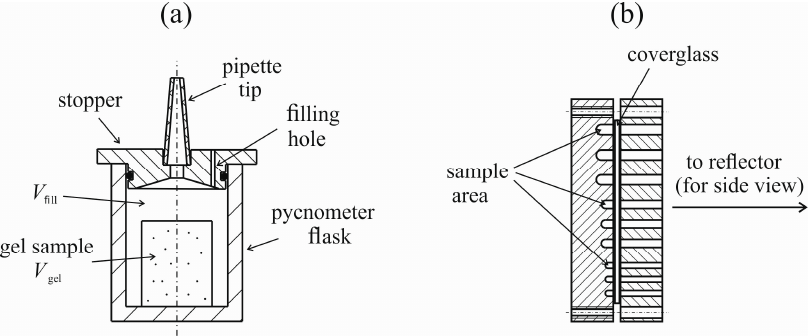
Figure 6. Measurement equipment for natural syneresis, cylindrical samples ( a ) [5] and gel droplets ( b ).